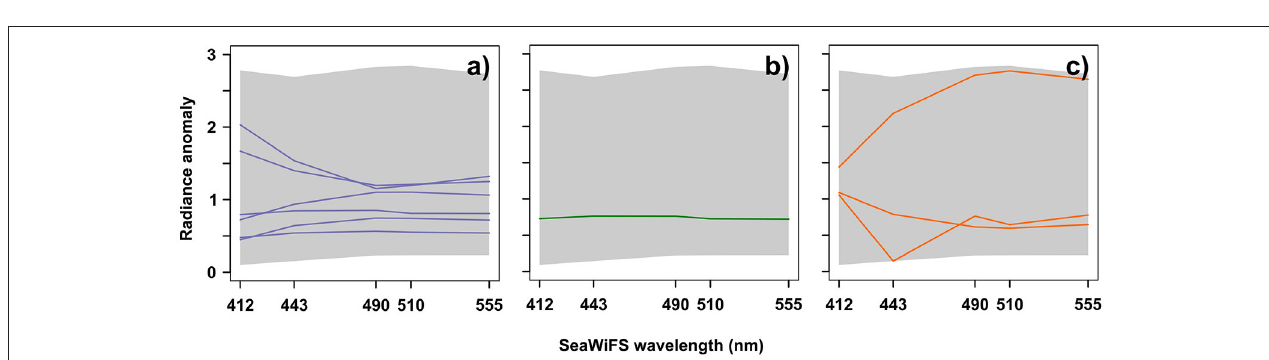
FIGURE 5 | Labeled-radiance anomaly spectra (reference spectra of Ra( λ )) classes*) for (a) assemblage characterized by Thalassionema nitzschoides ; (b) assemblage characterized by Thalassiosira spp.; and (c) assemblage characterized by Rhizosolenia imbricata . The gray background represents the entire diversity 5 (minimum and maximum) of North Sea radiance anomalies spectra. X axis represents the five SeaWiFS wavelengths and the Y axis represents the radiance anomaly according to Equation (1). *The reference spectrum of a Ra( λ ) class is computed from the Self-Organizing Map algorithm (SOM). It represents a compression of the information contained in all initial Ra( λ ) spectra assigned in this specific Ra( λ ) class by the SOM algorithm (Ben Mustapha et al.,